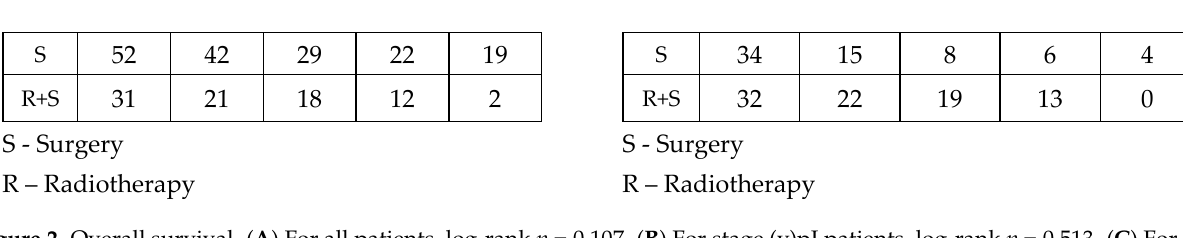
Figure 2. Overall survival. ( A ) For all patients, log-rank p = 0.107. ( B ) For stage (y)pI patients, log-rank p = 0.513. ( C ) For stage (y)pII patients, log-rank p = 0.616. ( D ) For stage (y)pIII patients, log-rank p =